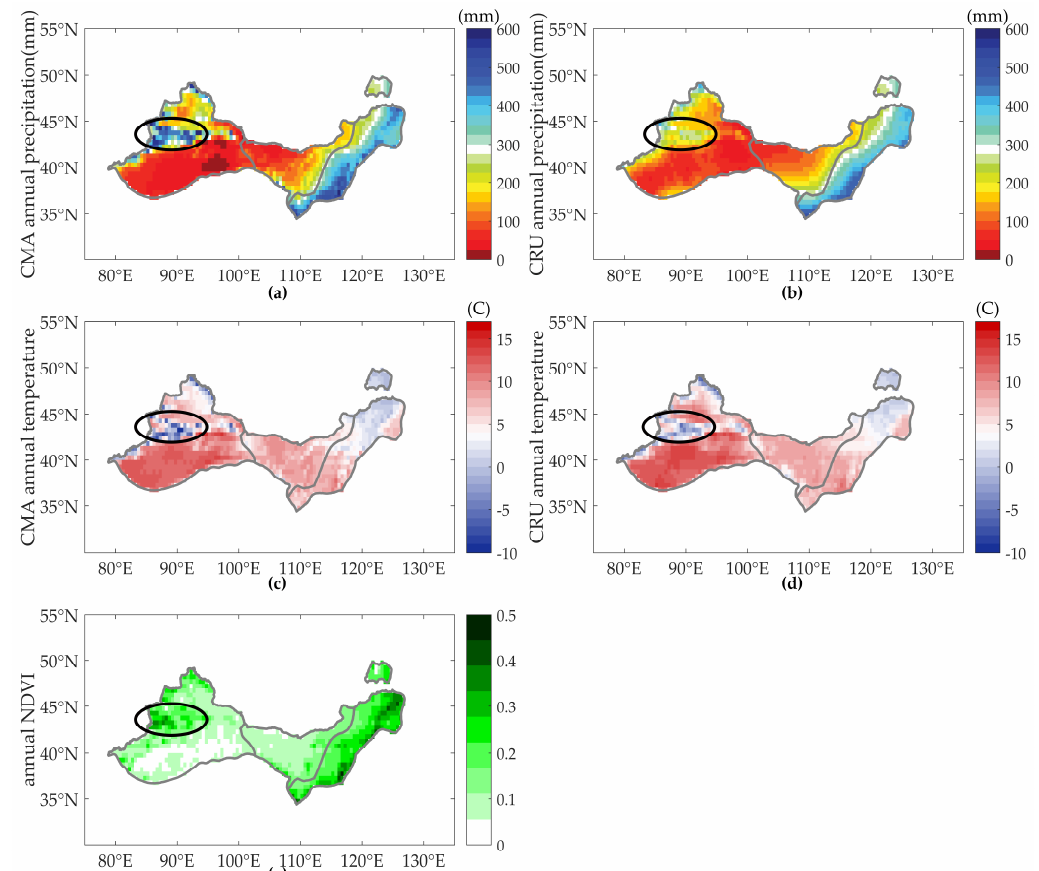
Figure 2. The distribution of the annual averages of the precipitation, temperature and NDVI during 1982–2012 over the drylands. ( a , b ) Precipitation (mm) records from CMA and CRU 3.22; ( c , d ) Temperature (°C) data from CMA and CRU 3.22; ( e ) NDVI from NDVI3g. Circled area denotes the western Tianshan Mountains.